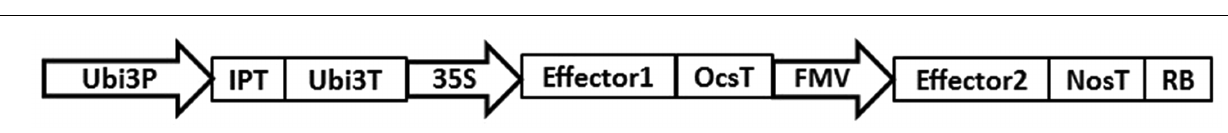
FIGURE 1 | Schematic of strategy for the targeted T-DNA insertion. The TALEN vector contains a pair of TALENs targeting the endogenous potato Ubi7 intron immediately 5 (cid:48) to the initiation codon for the first ubiquitin monomer. The LB was removed and an ipt overexpression cassette was put next to the TALEN expression cassettes on the left side of T-DNA. The donor vector contains a promoter-less mutated potato ALS gene ( mStALS ) next to the RB and the nptII cassette. Upon Agrobacterium -mediated transformation, expression of TALENs generate DSB at the endogenous target, once the donor T-DNA is inserted into this endogenous site, the endogenous promoter will drive the expression of mStALS expression and resulted targeted events can be selected out on herbicide containing medium. The targeted events can also be PCR confirmed by using a primer in the mStALS gene (opened arrow) paired with a primer within the endogenous Ubi7 promoter (solid arrow).